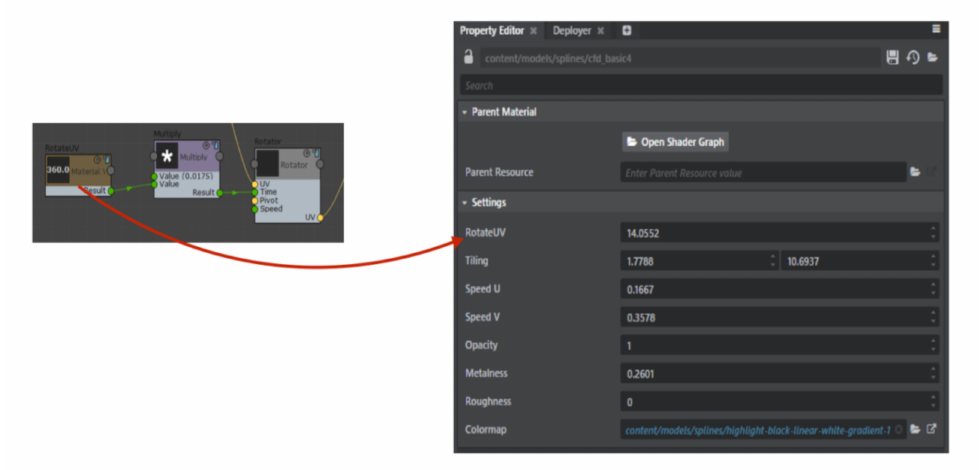
Figure A2. Step 1 rotator in the CFD animation